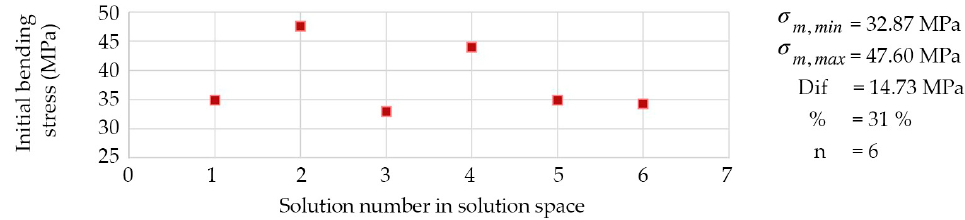
Figure 20. Evolution of initial bending stress for 75 × 30 mm 2 cross-section in Step 1.